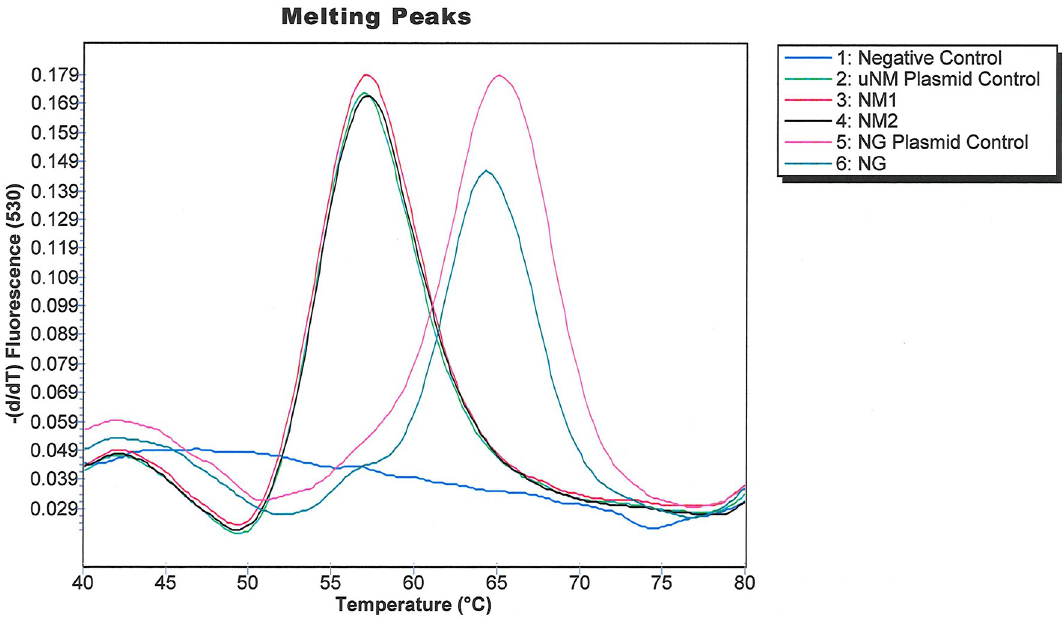
Fig 1. Melting curves of two local US_NmUC isolates (NM1 and NM2), the NG positive control, and another local NG isolate. The shift in melt curve peaks were clearly distinguishable, and separated by approximately 10˚C.